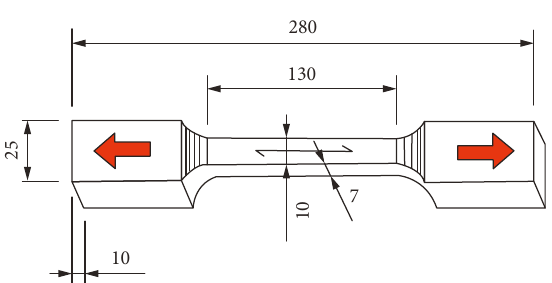
Figure 7: Schematic illustration of the axial tensile test